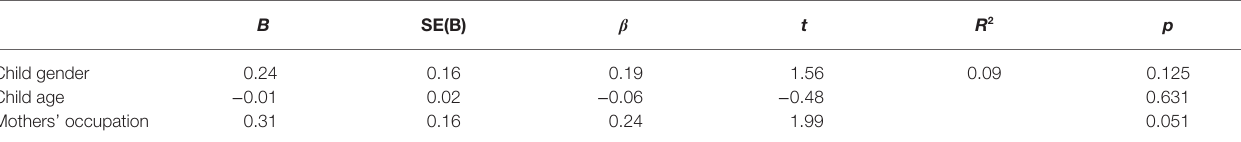
TABLE 2 | Linear regression for the effects of mothers’ occupation on childcare center children’s communal occupational aspirations while controlling for child gender and age. B